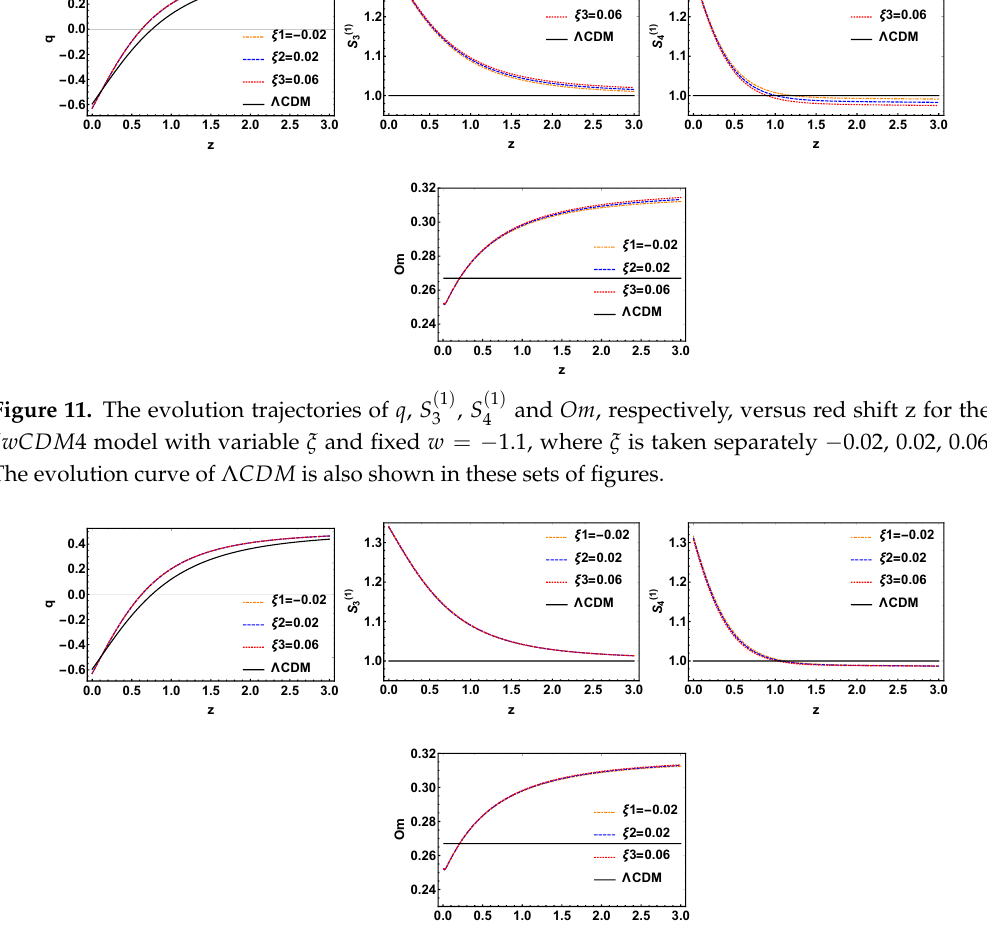
( 1 ) ( 1 ) , S and Om , respectively, versus red shift z for the 3 4